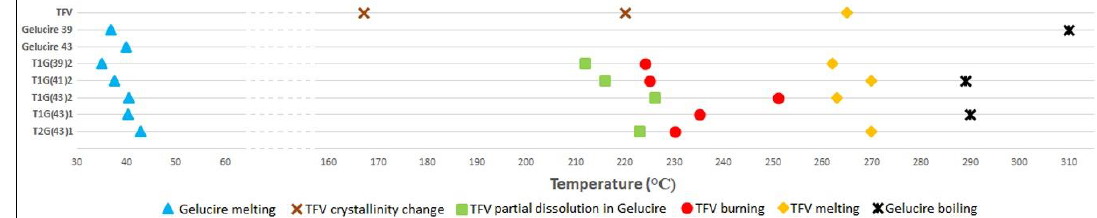
Figure 4. Diagram of the changes visualized during the observation of TFV, Gelucire® and the granules by hot stage microscopy.